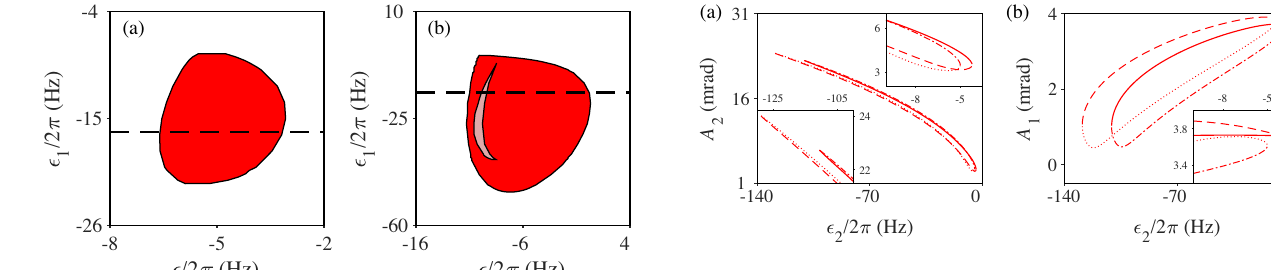
FIG. 8. The dependence of the amplitude of the stable vibra- tions states (solid line) and saddle points (dashed, dotted, and dash-dotted lines) of (a) mode 2 and (b) mode 1 on the detuning frequency of the parametric modulation of mode 2. When there is no energy transfer from mode 2 to mode 1, mode 2 displays ordinary parametric resonance, and mode 1 remains at zero amplitude. These stationary states are omitted from the plot for clarity. The insets enlarge to show the merging of the branches at the two ends.